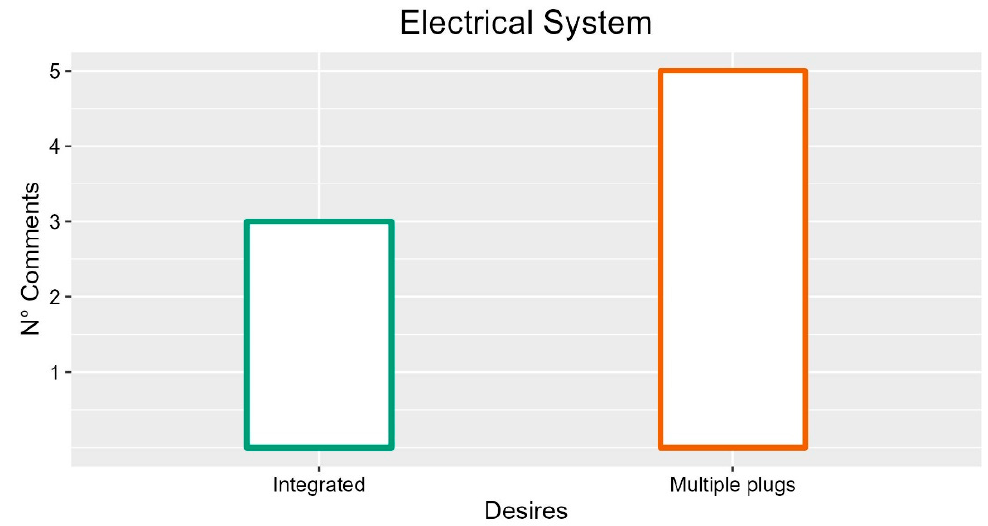
Figure 5. Graphical representation of desires with more occurrences for the Electrical System theme.